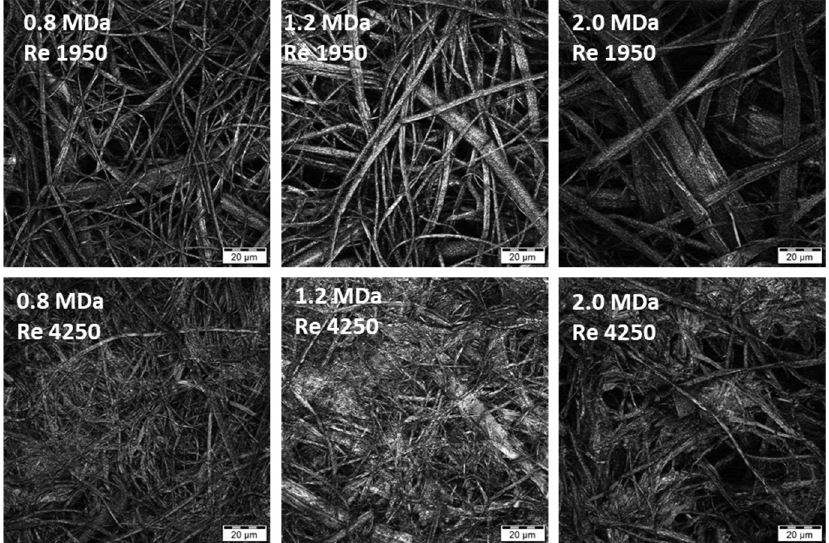
Figure 7. Microscopic images of the textile microstructure for HA M W of 0.8, 1.2 and 2.0 MDa and two selected Re (laminar and turbulent flow). (Olympus LEXT OLS5000 3D Measuring Laser Microscope, MPlanApo N 100 x/0.95 LEXT.)